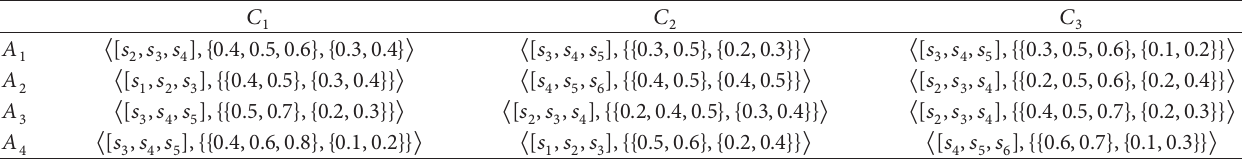
Table 1: Dual hesitant fuzzy triangular linguistic decision